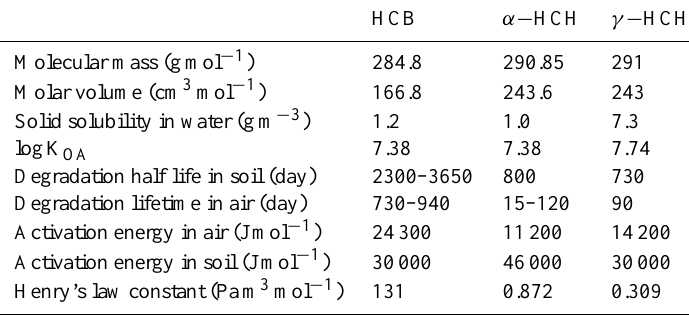
Table 1. Physical/chemical properties of HCB and HCHs at air temperature of 20–25 ◦ C ∗ .